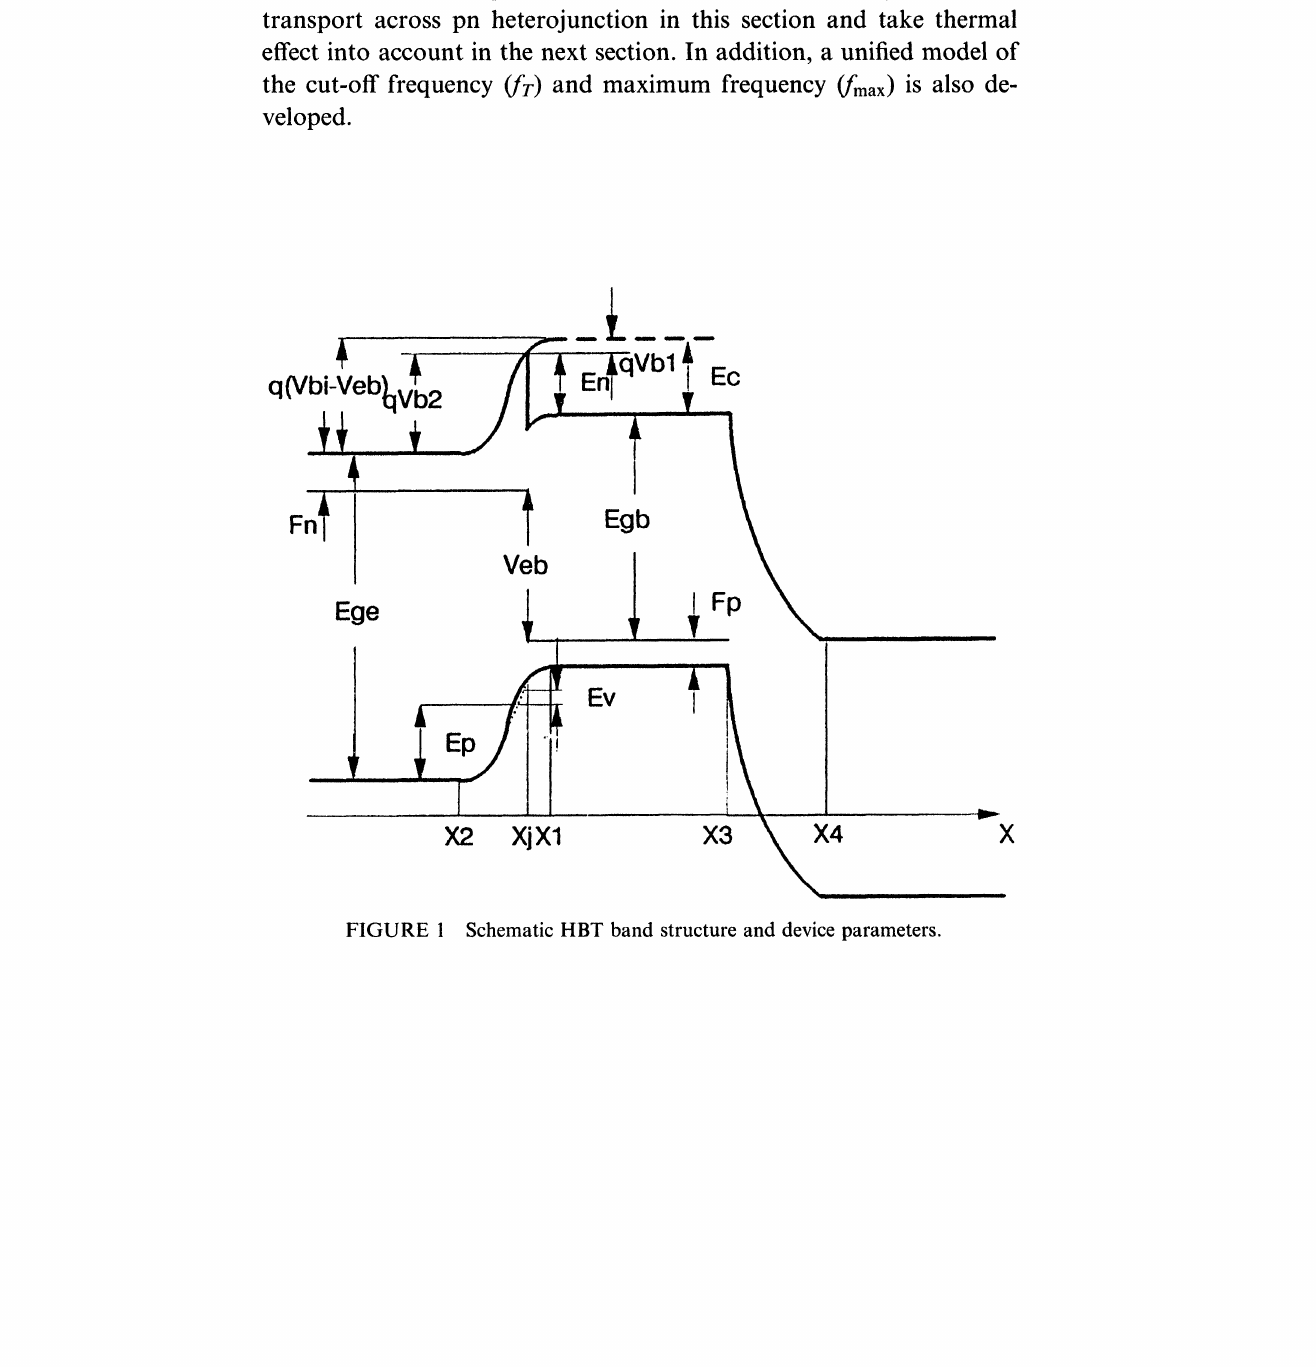
FIGURE Schematic HBT band structure and device